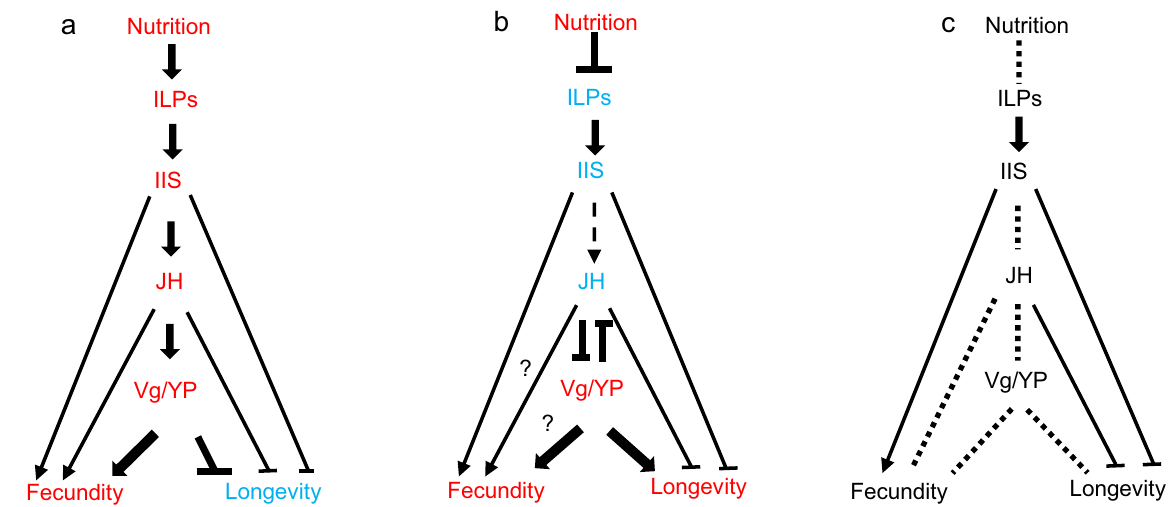
Fig. 1 Models of IIS-JH-Vg/YP circuit to explain the fecundity – longevity trade-off and its reversal in social insects. Although the TOR pathway appears to play a role in fecundity and longevity of social insects, it is not addressed in the “ rewiring hypothesis ” of the IIS-JH-Vg/YP circuit and therefore not included in this fi gure. a The typical circuit as revealed for solitary insects like the fruit fl y Drosophila melanogaster , b a remolded circuit as indicated by results for honeybee queens, Apis mellifera , and c a rewired circuit as hypothesized for social insects. Adapted from Rodrigues and Flatt 8 and Corona et al. 9 . Solid and dashed arrows represent direct versus indirect activation, respectively, question marks indicate unclear relationships, stop bars indicate repression, dashed lines indicate potential rewiring points, red indicates upregulation, and blue indicates downregulation. For a more detailed explanation, see main